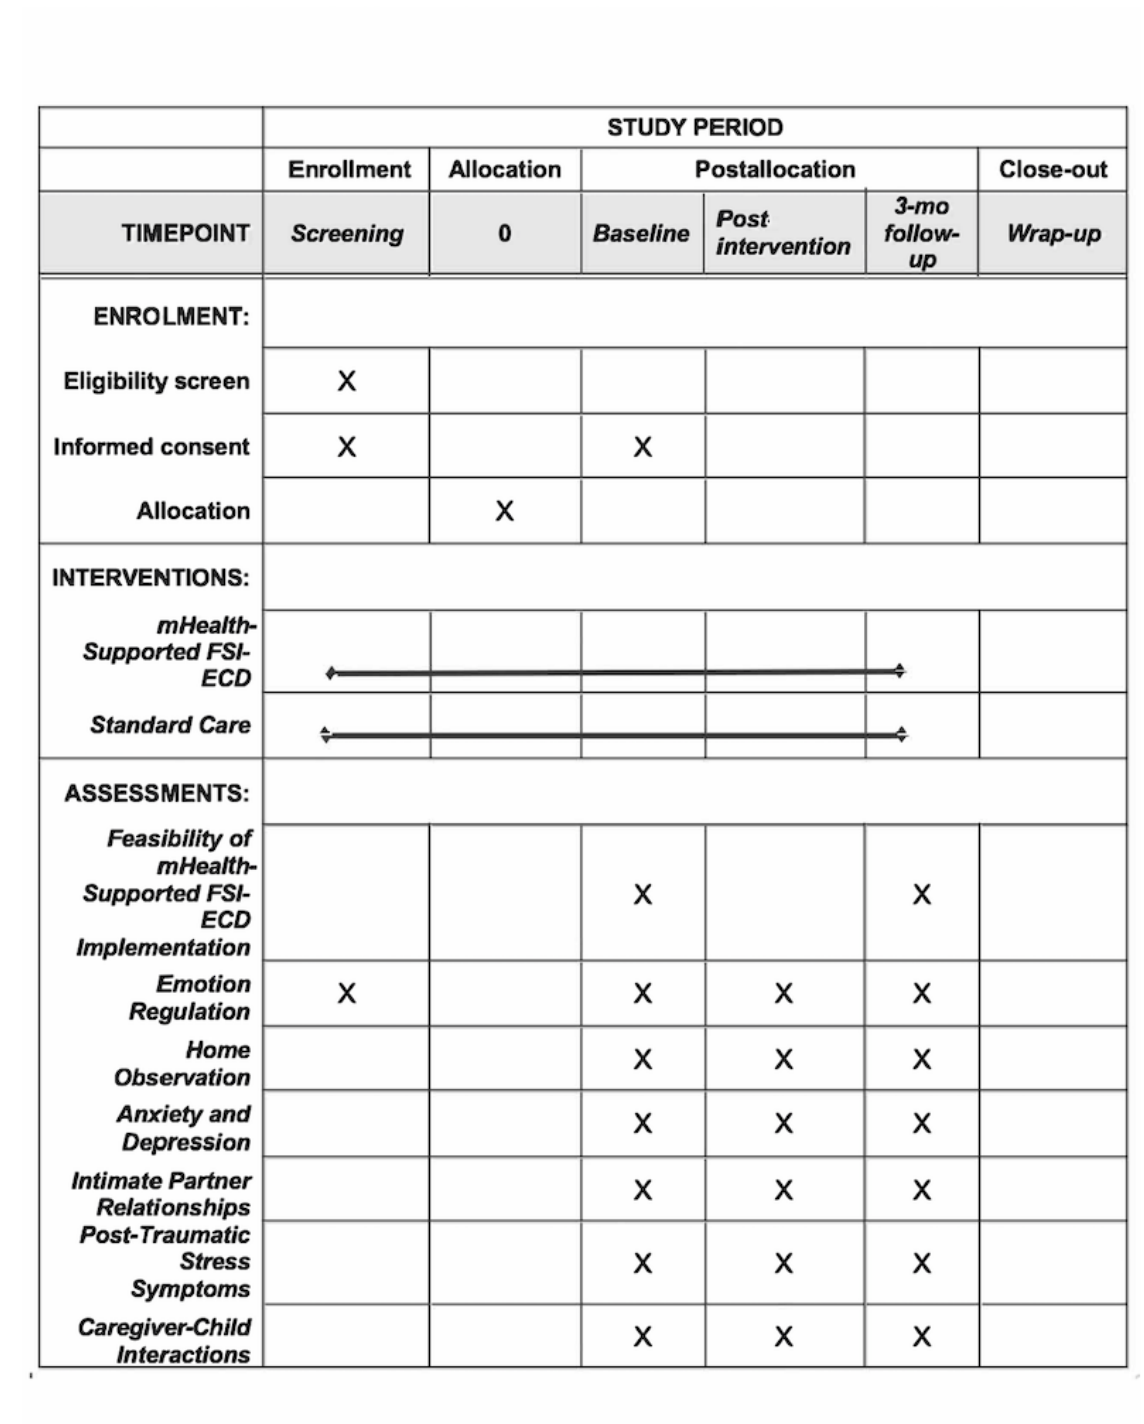
Figure 1. SPIRIT Schedule of Enrollment, Interventions, and